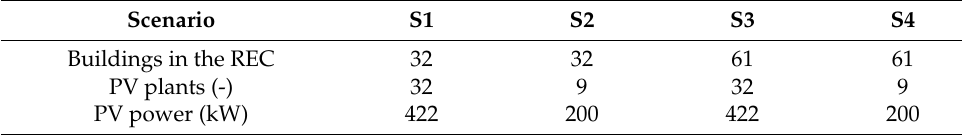
Table 2. Summary of the simulated